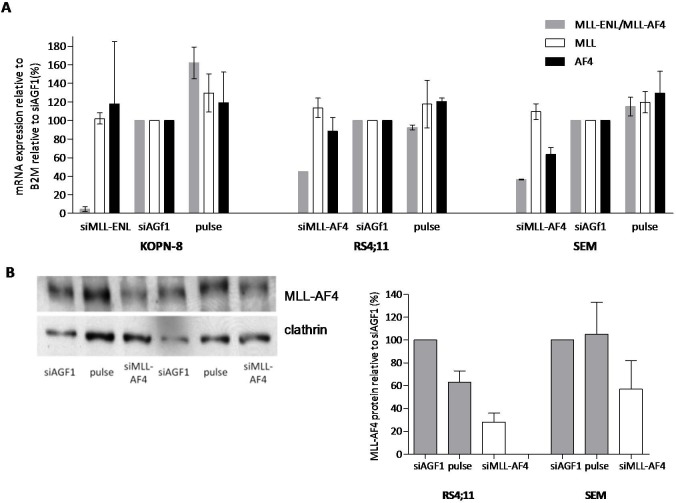
siRNA-mediated knock-down significantly decreases MLL fusion expression levels.(A) mRNA expression levels of MLL-ENL (grey), wild-type MLL (white), and wild-type ENL (black) in KOPN-8 cells, or MLL-AF4 (grey), wild-type MLL (white) and wild-type AF4 (black) in RS4;11 and SEMK2 cells after transfection with active siRNA directed against the absent target AML1/MTG8 (siAGF1), empty pulse (no siRNAs), and siRNAs directed against MLL-ENL and MLL-AF4 respectively. Shown is the average mRNA expression of two experiments ± standard error of the mean. (B) Protein expression levels of MLL-AF4 in RS4;11 and SEMK2 shown by western blot (left panel). The western blot was probed with antibodies against the N-terminus of MLL to detect MLL-AF4. Clathrin was used as a loading control. The graph (right panel) shows western blot quantification of MLL-AF4 protein expression relative to clathrin with the empty pulse control set at 100%.